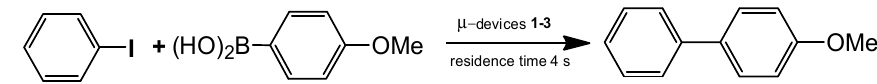
( c ). (Reprinted from [62]). the interface of a laminar flow inside a microchannel reactor (b) and high-resolution SEM image of